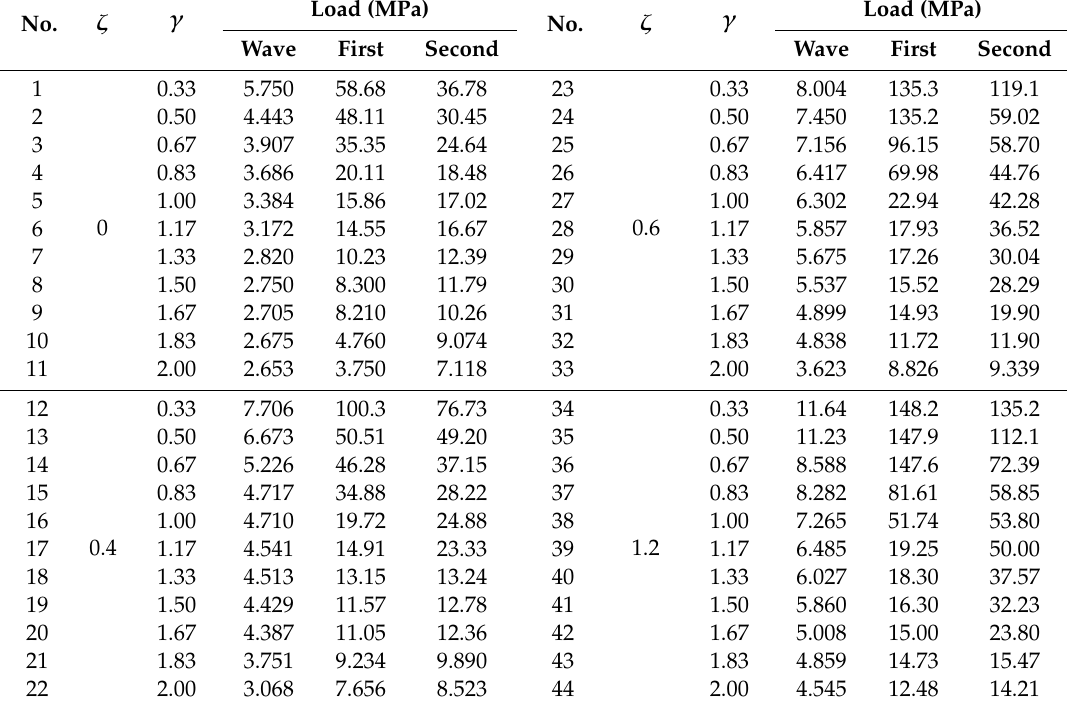
Table A1. Wall pressure loads under di ff erent ζ and γ